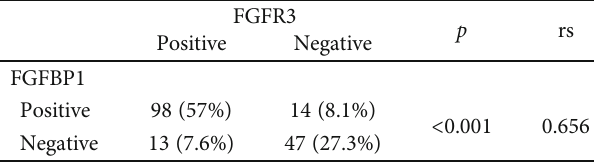
Table 5: Correlation between FGFR3 and FGFBP1.